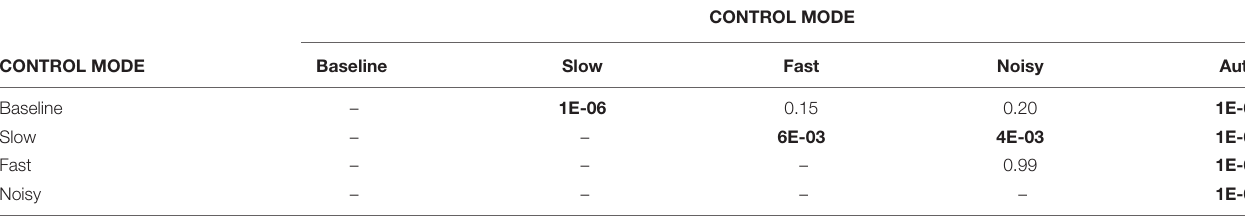
TABLE 3E | Post hoc comparisons ( p -values) for performance across control modes on rigid surface.